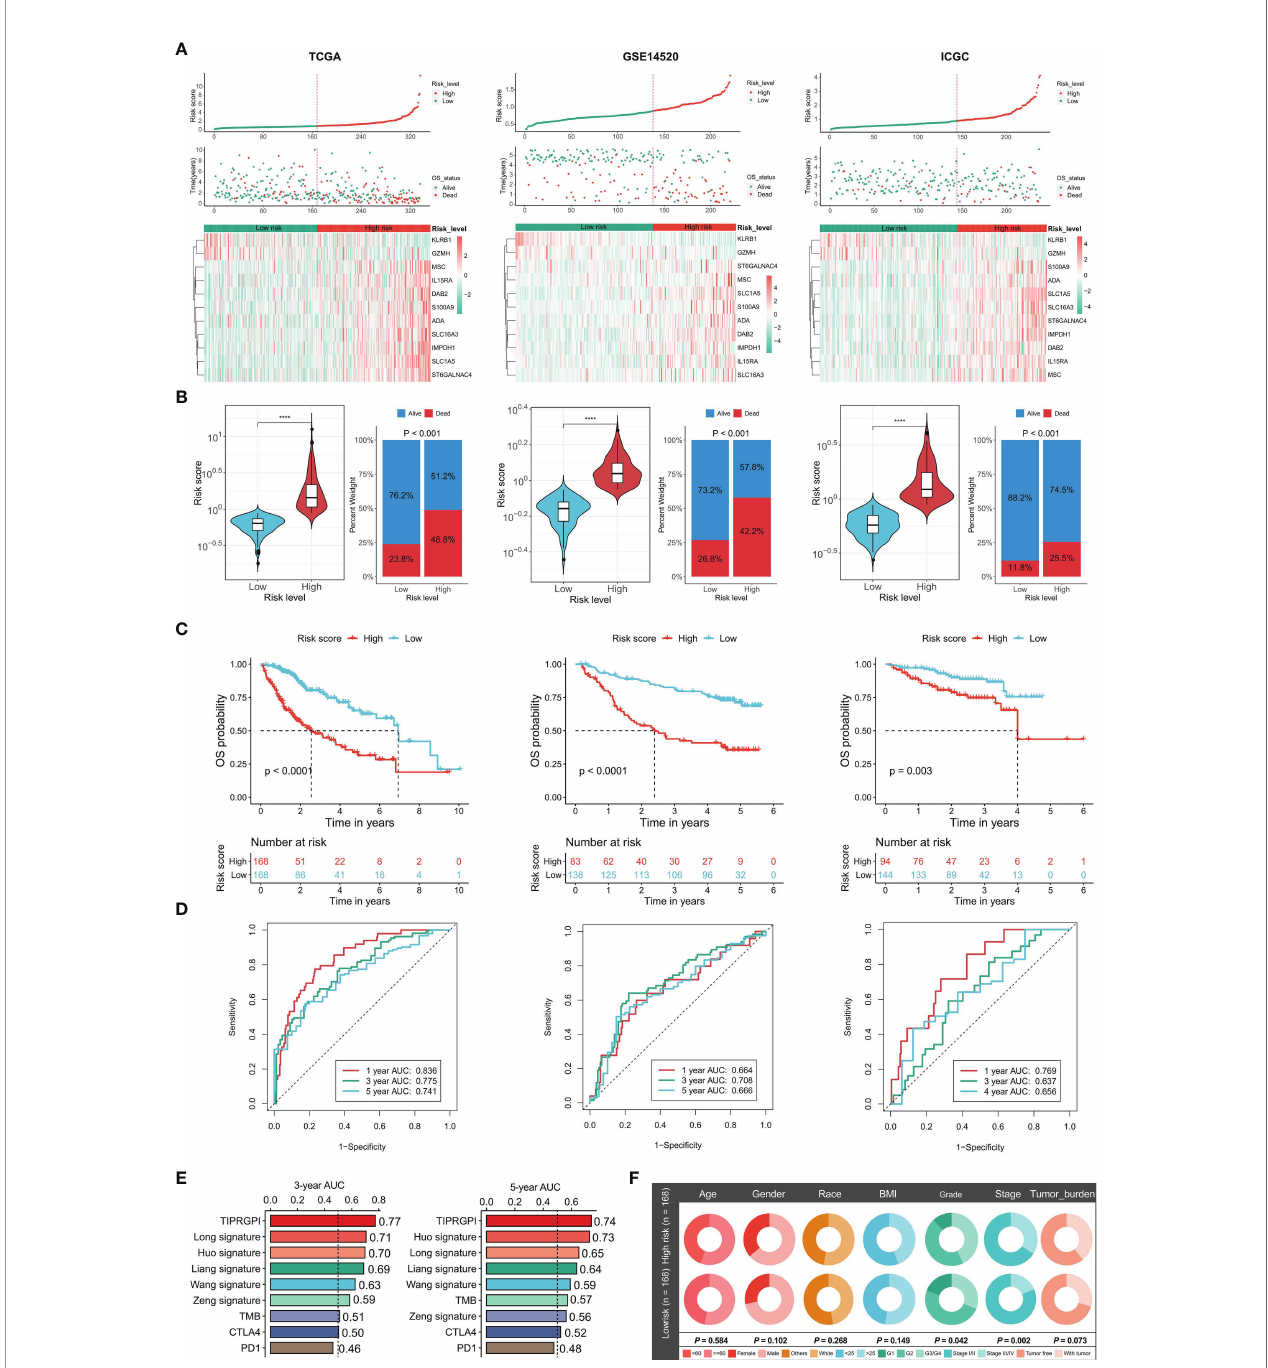
FIGURE 4 | Validation of the TIPRGPI predicting model and performance analysis in HCC. (A) Risk score distribution, survival status, and the expression of 11 TIPRGPI genes for patients in low- and high-risk groups from TCGA training dataset and two validation datasets (GSE14520 and ICGC-LIRI-JP). (B) Risk score and mortality rate of patients in low- and high-risk groups from three datasets. (C) Kaplan-Meier survival curves showing the comparison of overall survival (OS) between the low- and high-risk groups from three datasets. (D) Time-dependent receiver operating characteristic (tROC) curves of three datasets. (E) The area under the ROC curve (AUC) in 3-year and 5-year survival for TIPRGPI and other published signatures and common immunotherapeutic biomarkers. (F) Correlation analysis between the TIPRGPI low-/high-risk groups and clinical traits ****P <